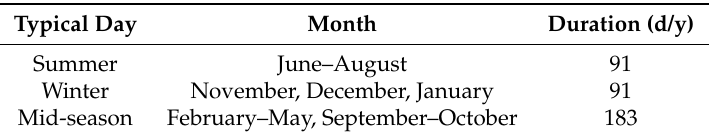
Table 1. Definition of typical days.